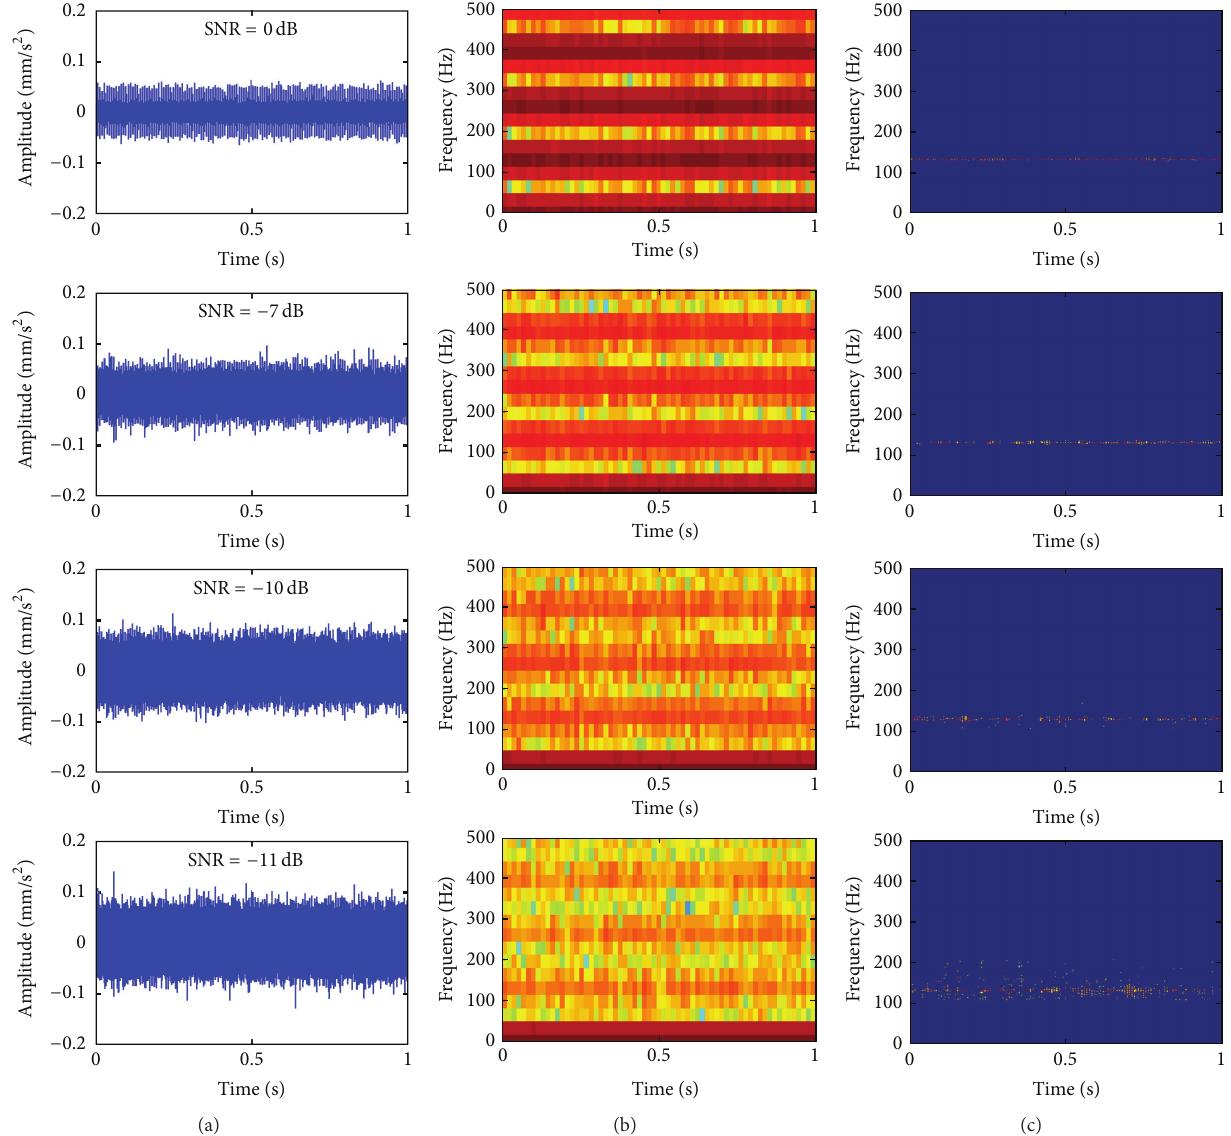
Figure 11: (a) The time domain waveforms of 𝑥 1 (𝑡) with different SNR; (b) the processing results of 𝑥 1 (𝑡) with different SNR by shock pulse time-frequency analysis method; (c) the processing results of 𝑥 1 (𝑡) with different SNR by PATFTM.